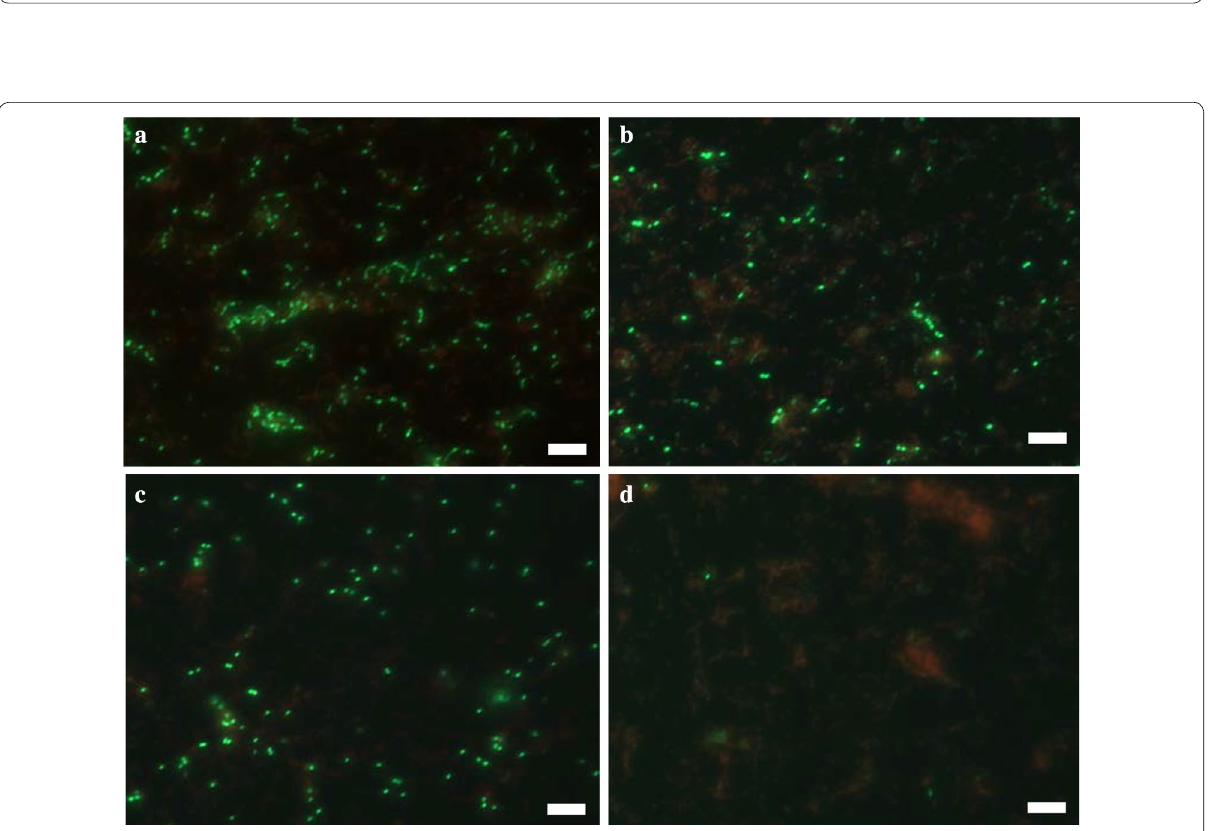
Fig. 4 Live/dead staining of S. mutans biofilms after treatment with CHX, DC, or concurrent treatment. a Without treatment. b Treatment with 5 μg/ mL CHX. c Treatment with 7 μA/cm 2 DC. d Concurrent treatment with 5 μg/mL CHX plus 7 μA/cm 2 DC. Bar